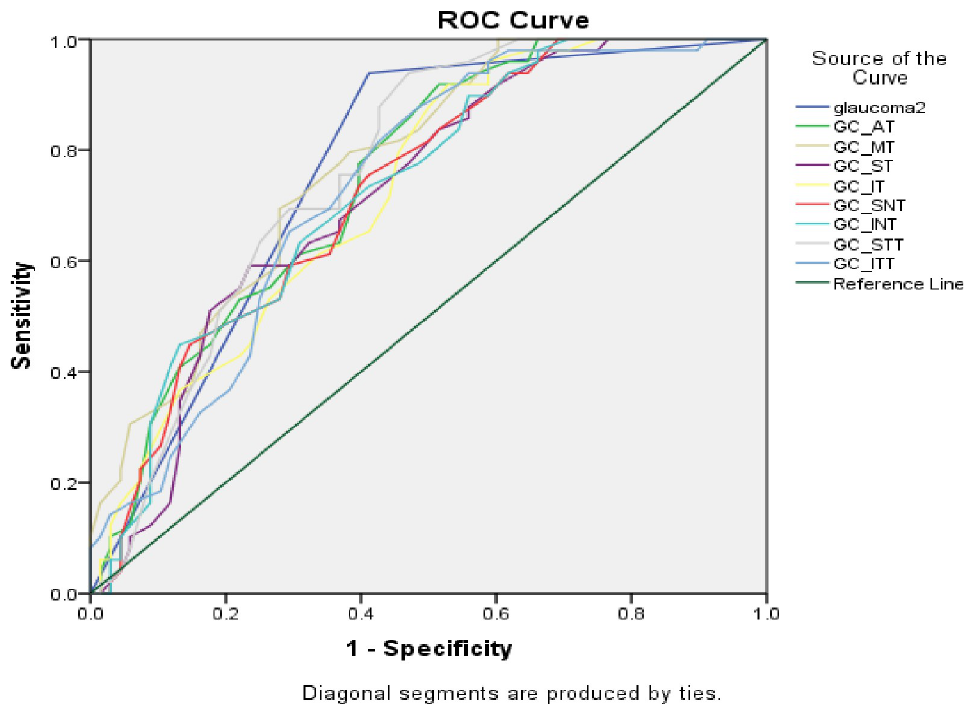
Fig 2. Receiver operating curve of GCIPL showing healthy versus glaucoma suspect & early glaucoma. GC-ganglion cell inner plexiform layer, AT-average thickness, MT-minimum thickness, ST-superior thickness, IT-inferior thickness, SNT-superonasal thickness, INT-inferonasal thickness, STT-superotemporal thickness, ITT-inferotemporal thickness.